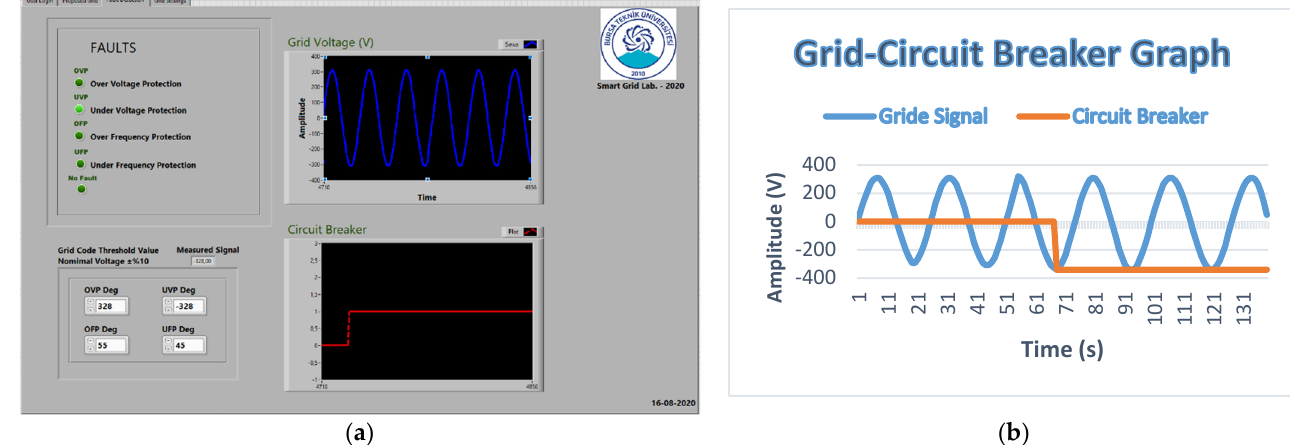
Figure 6. ( a ) UVP condition in DGPS; ( b ) status of grid voltage and CB.